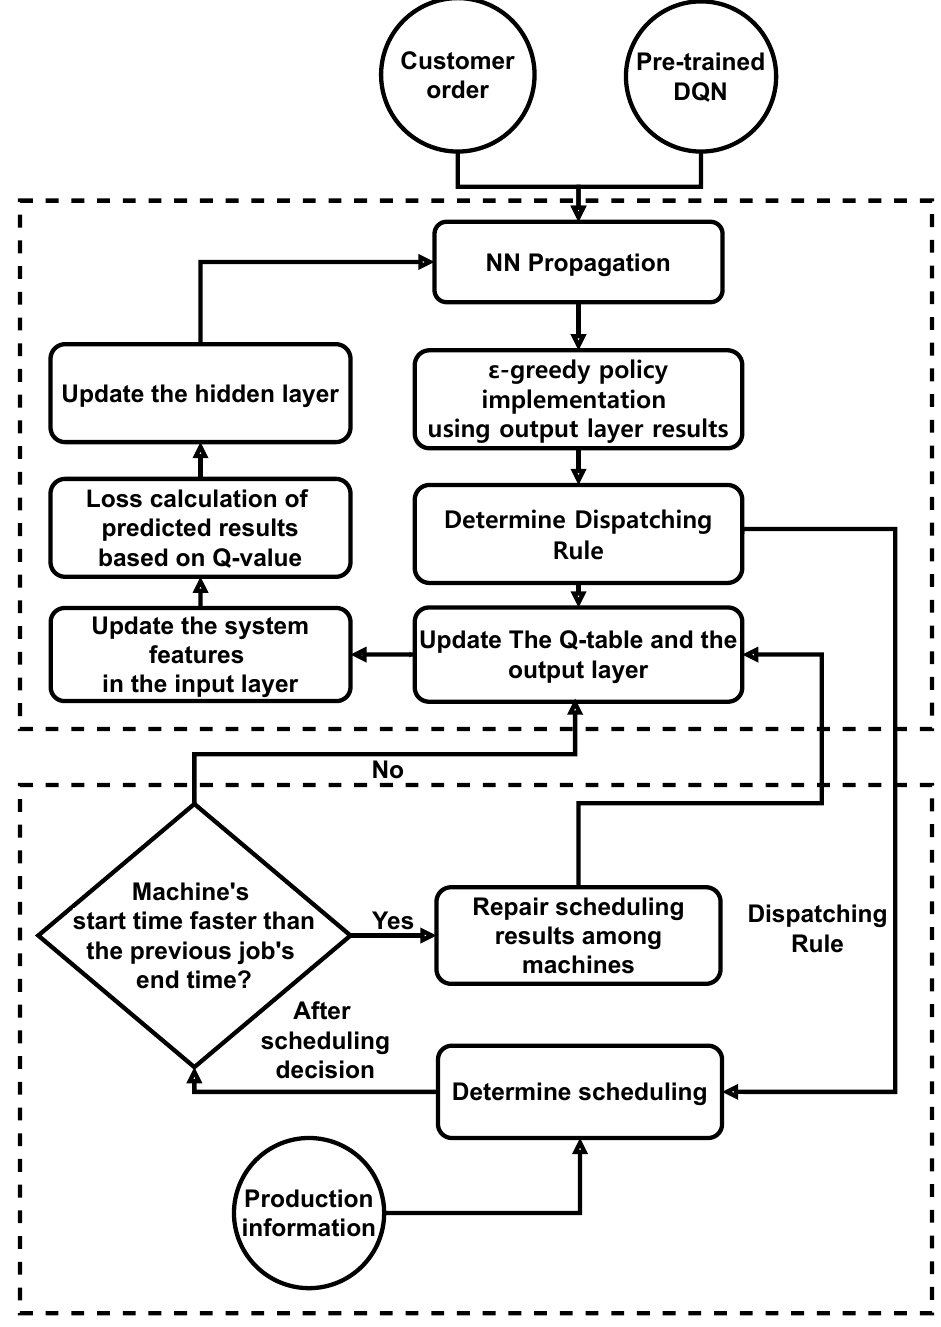
Figure 4. Job shop scheduling